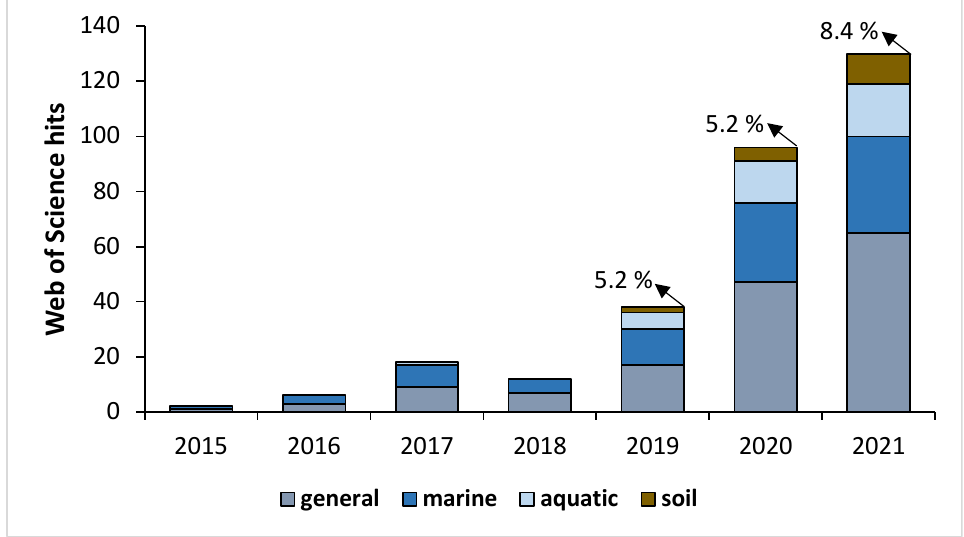
Figure 1. Web of Science (Clarivate) hits for different search term combinations (microplastic + heavy metal + “term”) (date: 27 November 2021).